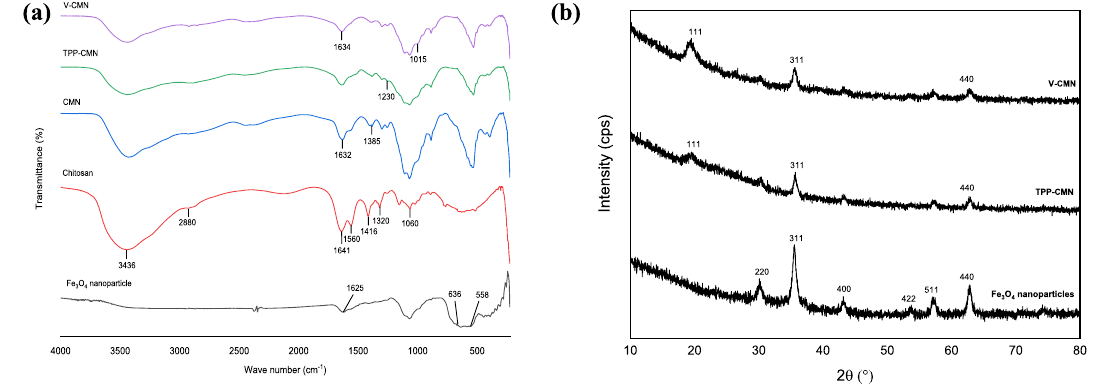
Figure 2. ( a ) FTIR spectra of Fe 3 O 4 nanoparticles, chitosan, chitosan coated Fe 3 O 4 nanoparticles, TPP-CMN, V-CMN nano-sorbents, and ( b ) XRD spectra of Fe 3 O 4 nanoparticles, TPP-CMN, and V-CMN